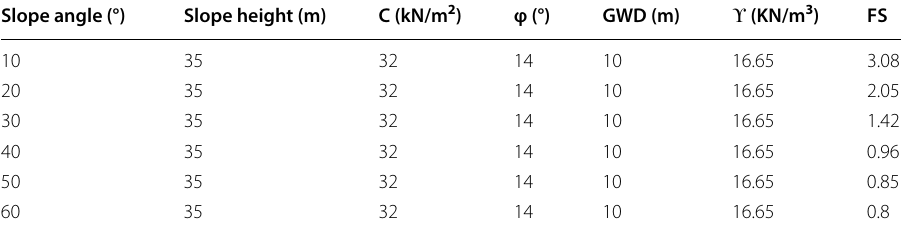
Table 10 Effect of slope angle on slope factor of safety